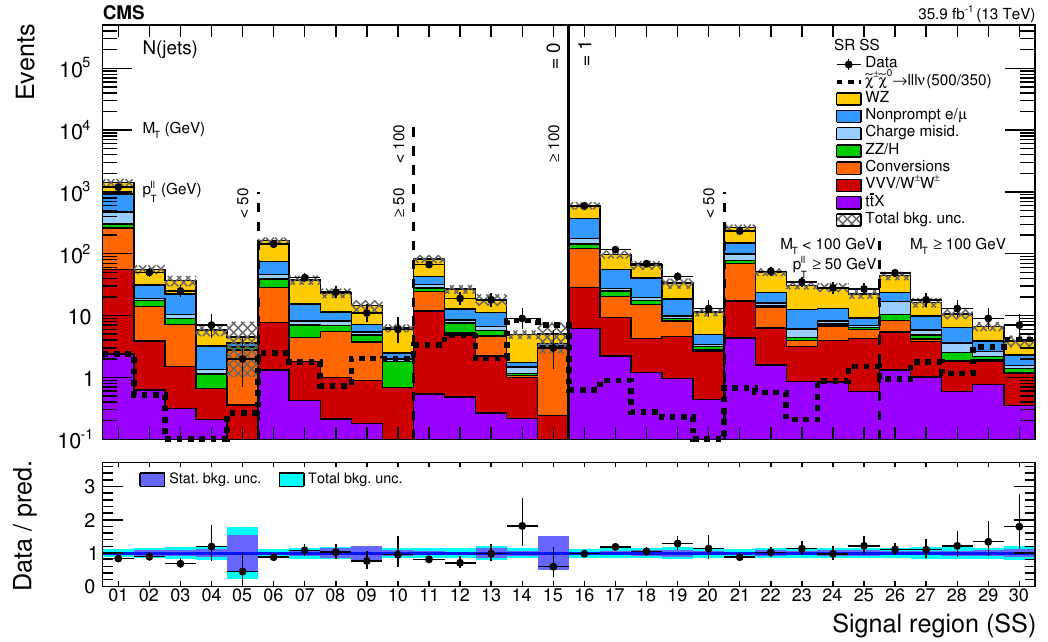
Figure 8 . Expected and observed yields comparison in the SS dilepton category. An example signal mass point in the (cid:13)avor-democratic model with mass parameter x = 0 : 05 is displayed for illustration. The notation is analogous to that used in (cid:12)gure 4.